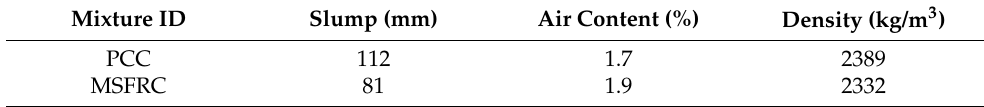
Table 6. Fresh concrete